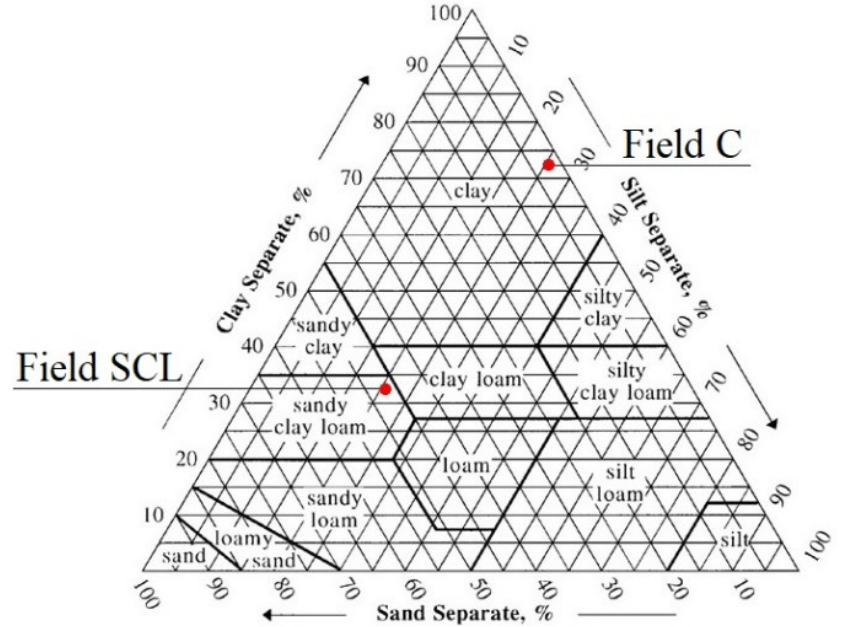
Figure 1. Textural soil classification of the two study areas [17]. Source: https://www.nrcs.usda.gov/wps/portal/nrcs/detail/soils/survey/?cid=nrcs142p2_054167 (accessed on 8 May 2022). 2.2. Apparent Soil Electrical Conductivity, Soil Samples, and Soybean Grain Yield Sampling grids were used as a positioning reference for measuring the ECa, collecting